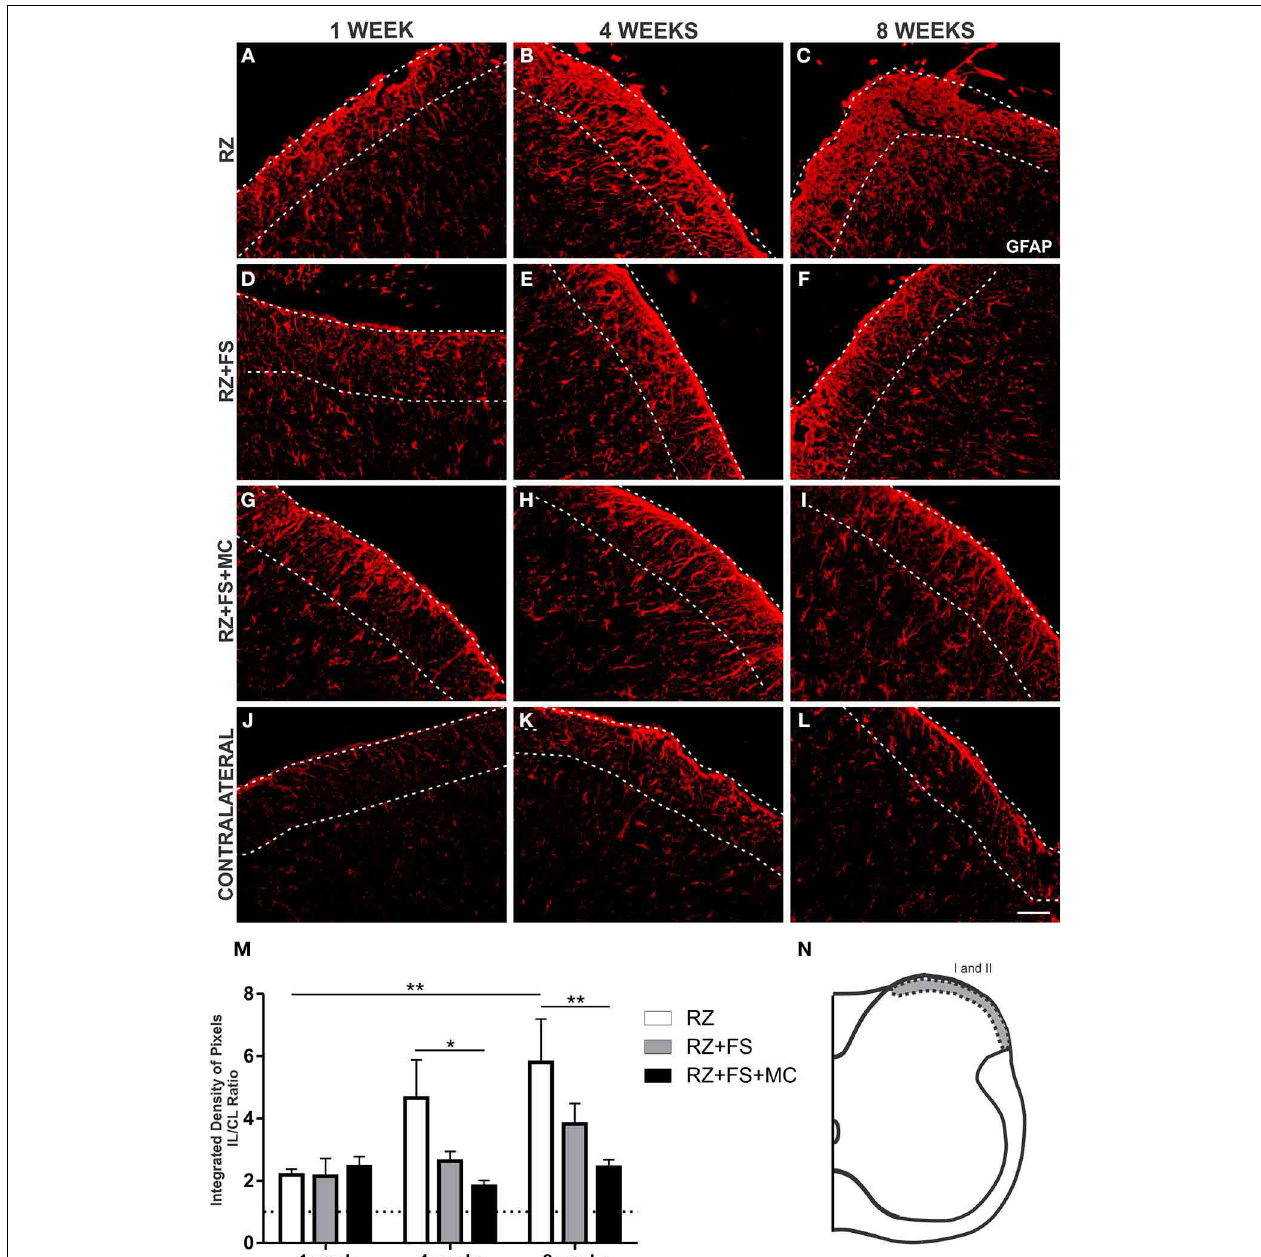
FIGURE 4 | Immunohistochemistry for glial fibrillary acidic protein (GFAP). (A–L) Representative images of RZ, RZ + FS and RZ + FS + MC, 1, 4, and 8 weeks post lesion. (M) Quantification (ratio IL/CL) of the integrated density of pixels, obtained in the region delimited by